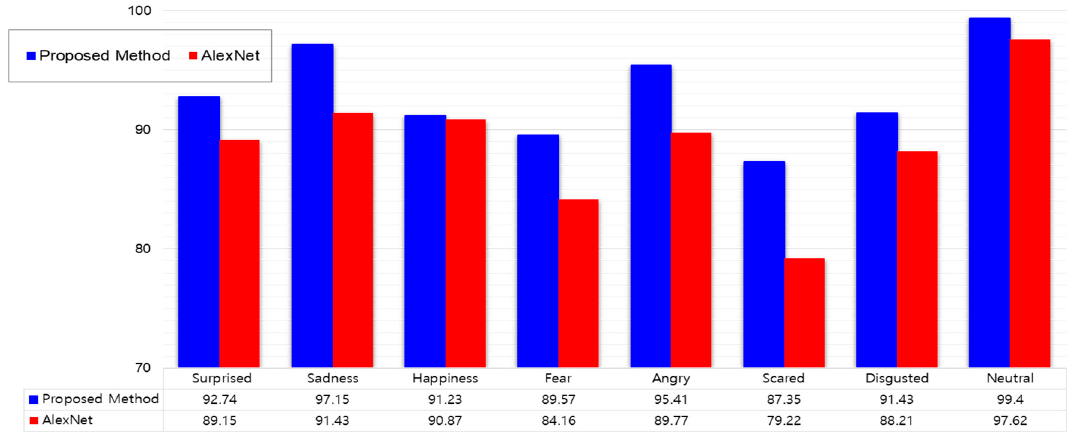
Figure 11. Comparison of emotion recognition accuracy of the proposed model and AlexNet.